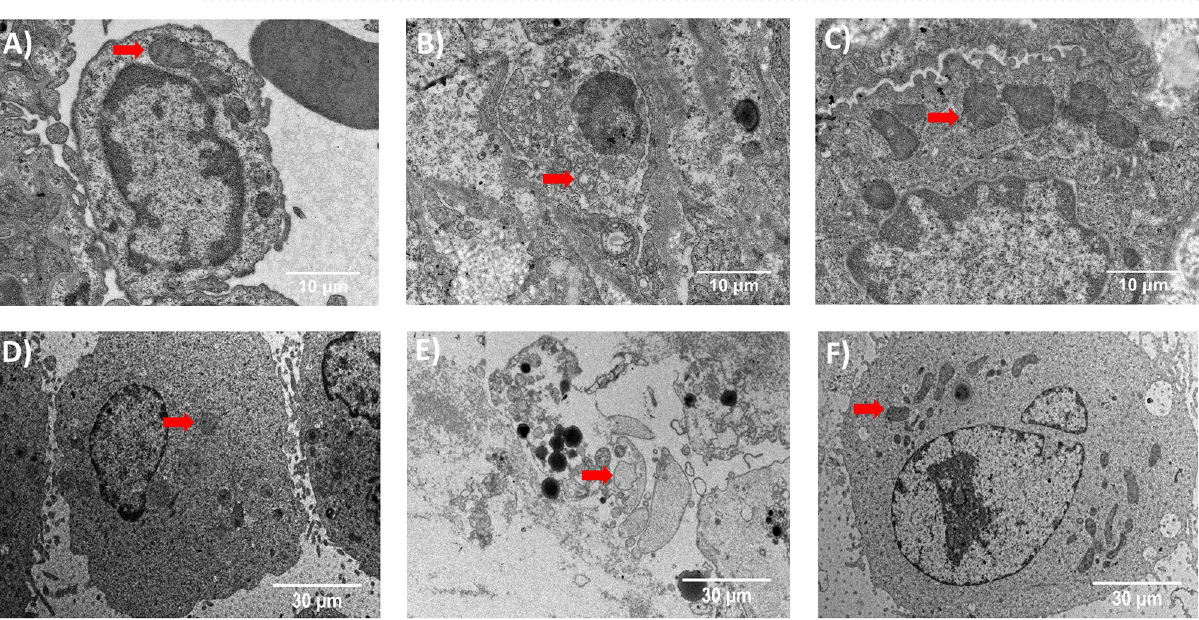
Figure 8. AH 2 QDS can protect mitochondria’s structural integrity. ( A – C ) The transmission electron microscope observed mitochondria’s structure in lung tissue. ( A ) the untreated control group did not receive any interventions. ( B ) PQ was given by gavage only at a concentration of 400 mg/kg in the PQ group. ( C ) in the PQ + AH 2 QDS group, 400 mg/kg of PQ was given to the stomach first, 2 h later, and 400 mg/kg of AH 2 QDS antidote was given. ( D – F ) The transmission electron microscope observed A549 cells’ mitochondrial structure. ( D ) the untreated control group, without any treatment. ( E ) in the PQ group, A549 cells were incubated with 200 μm PQ. ( F ) A549 cells were incubated with 200 μM AH 2 QDS and 200 μM PQ in the PQ + AH 2 QDS group. The mitochondria have been marked with red arrows in the